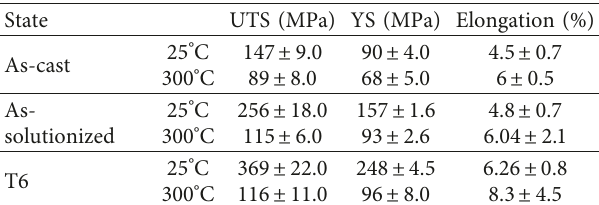
Table 2: Tension properties at 25 ° C and 300 ° C of the A different